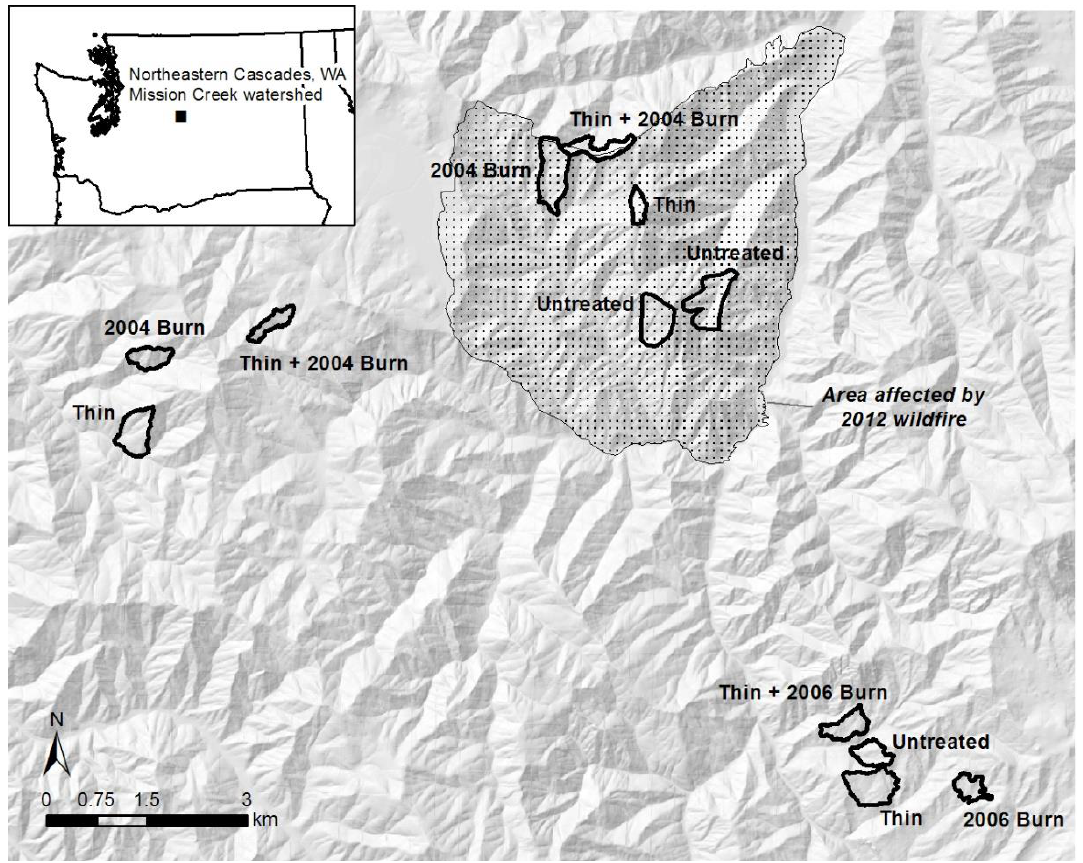
Figure 1. Geographical distribution and fuels treatments of the 12 experimental units. Treatments included factorial combinations of thinning and prescribed burning in either 2004 or 2006. Treatments were randomly assigned among units with some re-allocation [42]. ‘Untreated’ refers to units that were neither thinned nor prescribed burned. The stippled polygon is the area affected by the 2012 Wenatchee Complex wildfire. Each unit contains six sample plots.